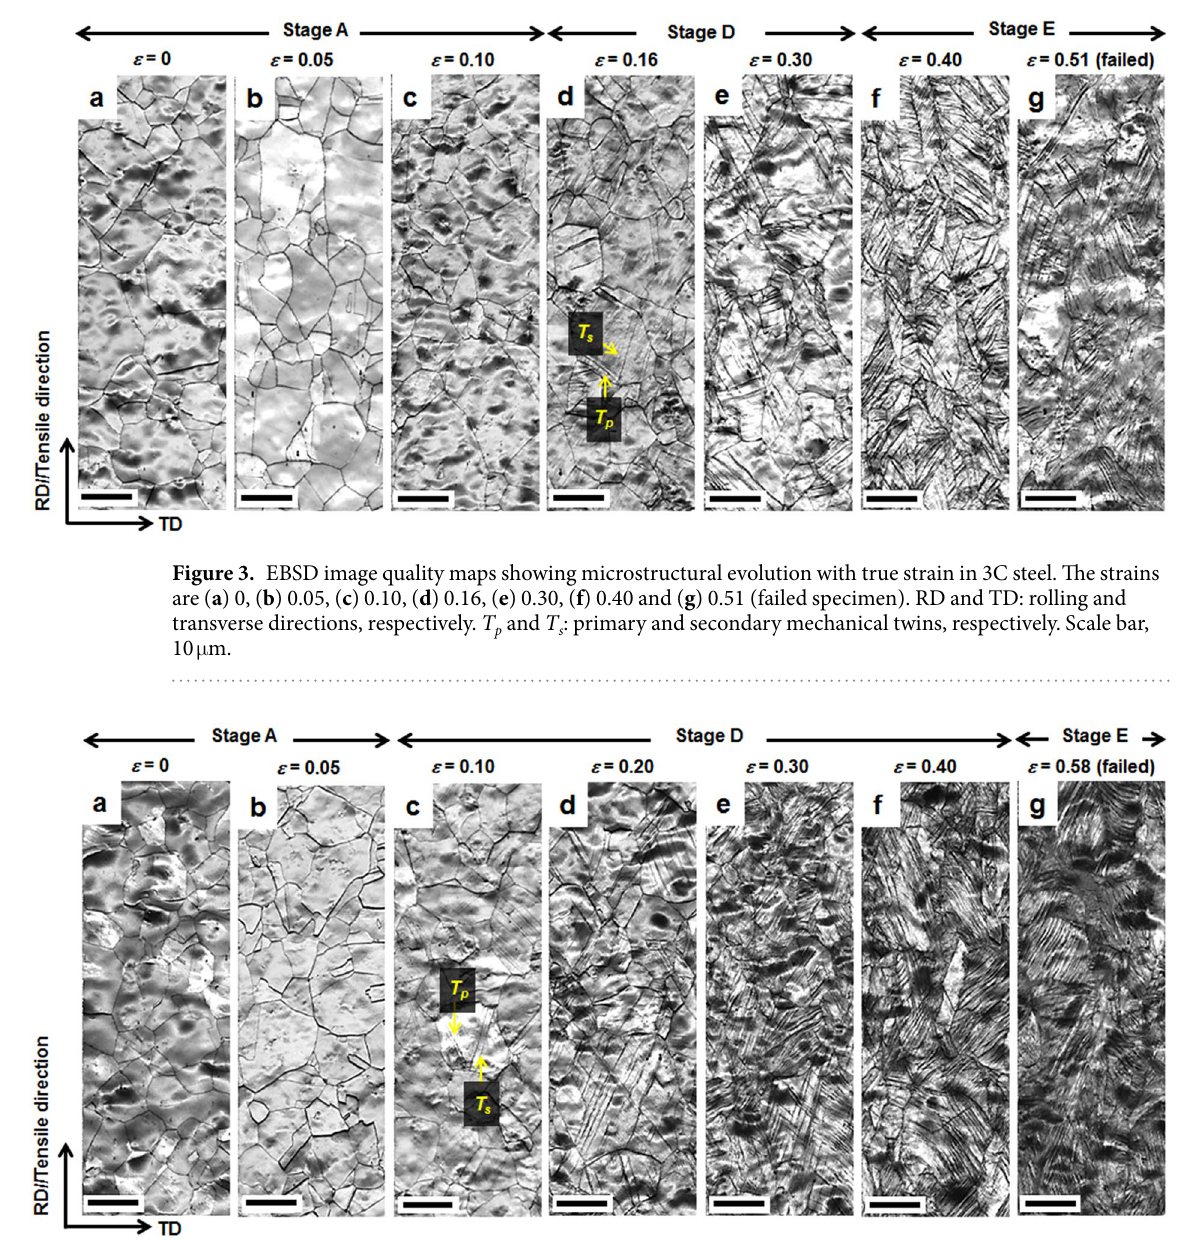
Figure 4. EBSD image quality maps showing microstructural evolution with true strain in 6C steel. The strains are ( a ) 0, ( b ) 0.05, ( c ) 0.10, ( d ) 0.20, ( e ) 0.30, ( f ) 0.40 and ( g ) 0.58 (failed specimens). RD and TD: rolling and transverse directions, respectively. T p and T s : primary and secondary mechanical twins, respectively. Scale bar, 10 μ